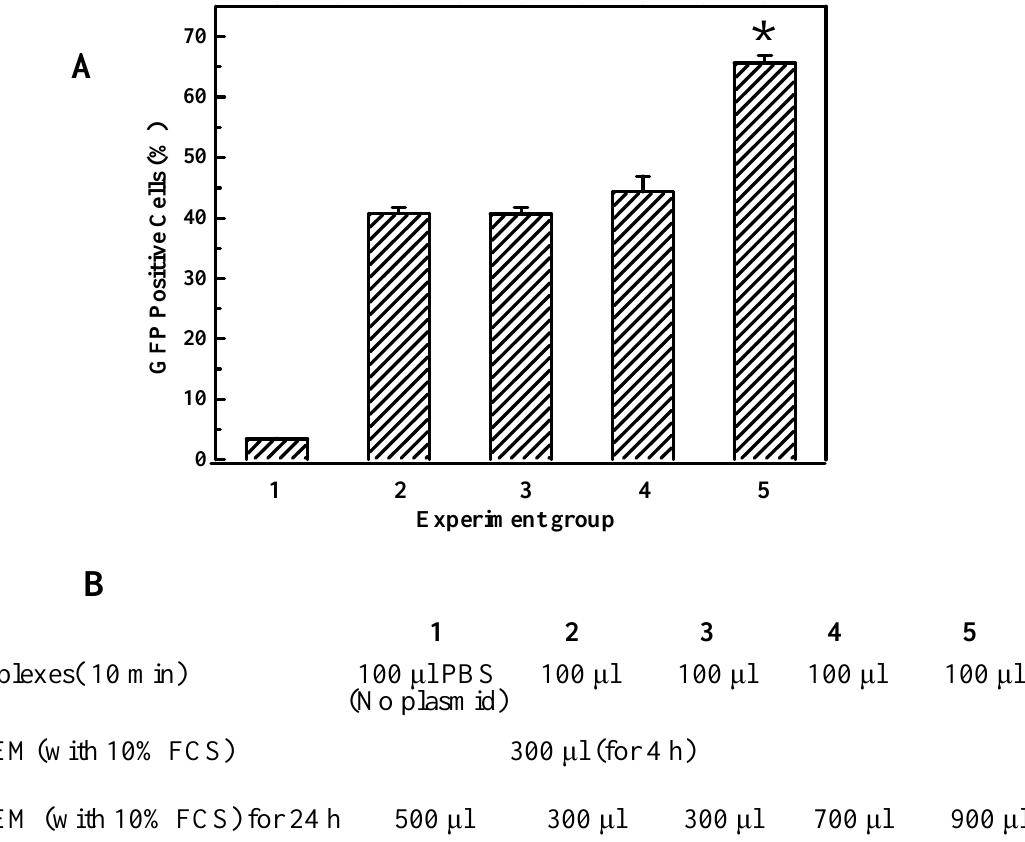
Figure 8. (A) The effect of different volume of DMEM on gene expression in CHO cells. (B) The DMEM volume for each group.EGDMA-PEI2000-4h was complexed with 2.0 µg DNA in PBS(100 µ l volume), then the polyplexes were incubated at 25°C for 10 min. The ratio of DNA/EGDMA PEI2000- 4h was 1:2. CHO cells were transfected in different amount of DMEM and incubated for 24 h. For group 2, transfection medium was replaced with 300 µl growth medium 4 h post transfection. *, p < 0.01 as compared to the condition of groups of 2, 3 ,4. N= 6, error bars represent standard